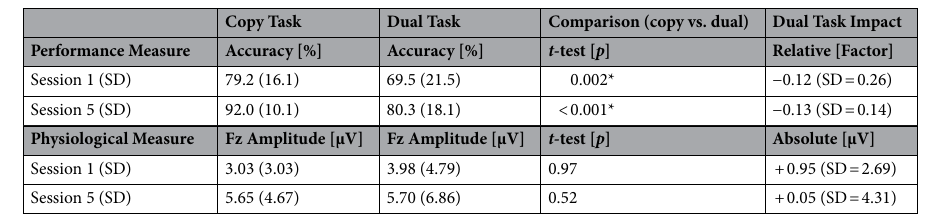
Table 2. BCI performance from copy and duals tasks and the impact of the dual task. Asterisks indicate